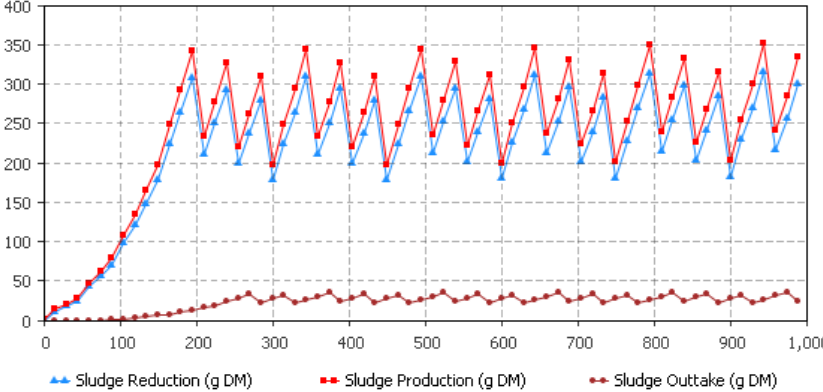
Figure 19. Graphical comparison between sludge production, sludge reduction, and sludge outtake assuming a TSS reduction of 90%, a HRT of 10 days, and an SRT of 80 days ( y ‐ axis). The days are displayed on the x ‐ axis.